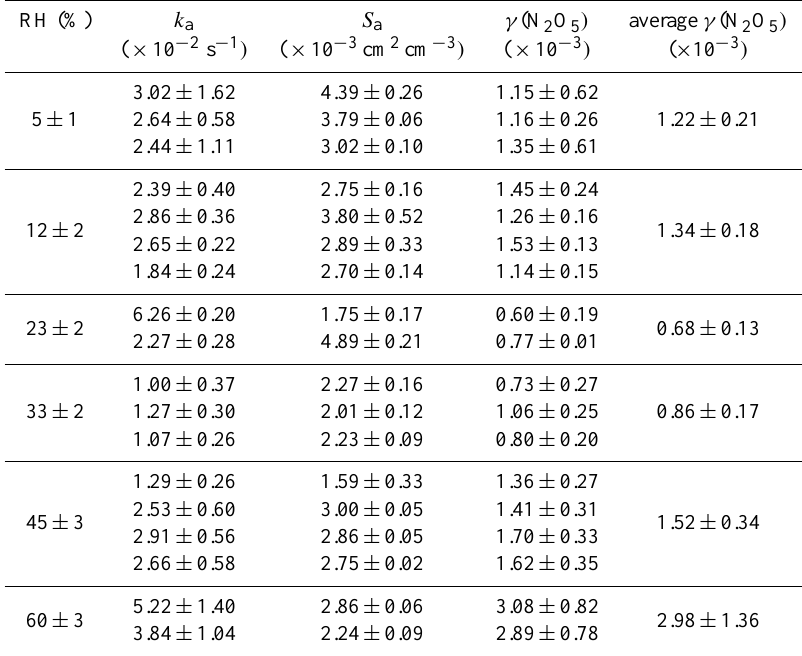
Table 1. Loss rate of N 2 O 5 on TiO 2 ( k a ) , total surface area of TiO 2 particles in the flow tube ( S a ) and uptake coefficients of N 2 O 5 onto TiO 2 aerosols, γ (N 2 O 5 ) , at different relative humidities. All the errors shown here are 1 σ statistically. RH (%) k a S a γ (N 2 O 5